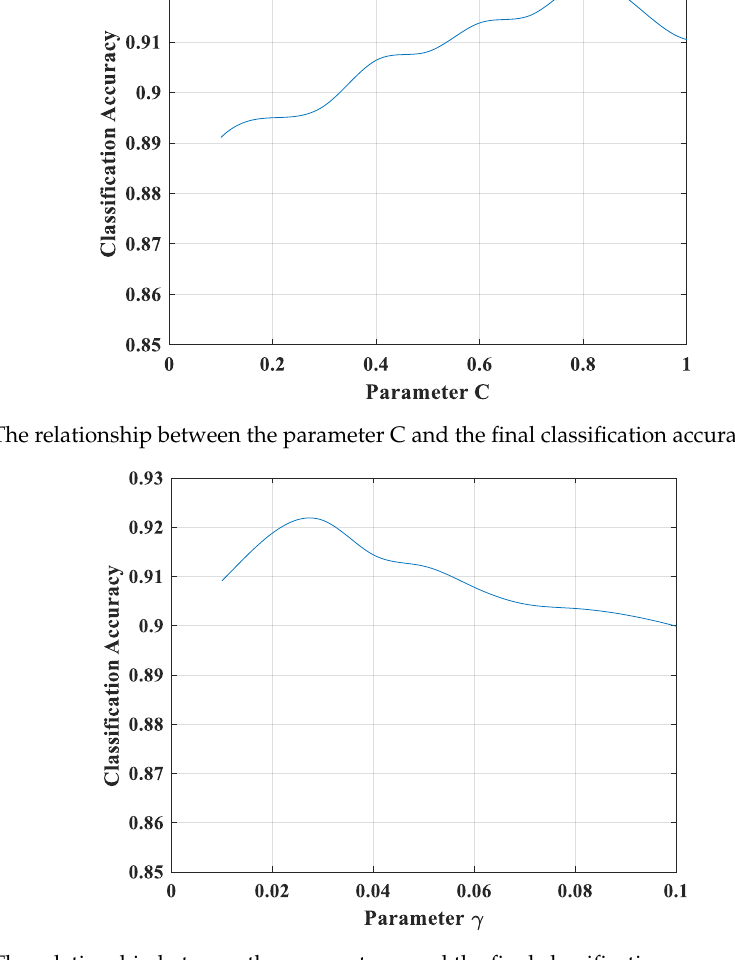
Figure 6. The relationship between the parameter γ and the final classification accuracy of the model.